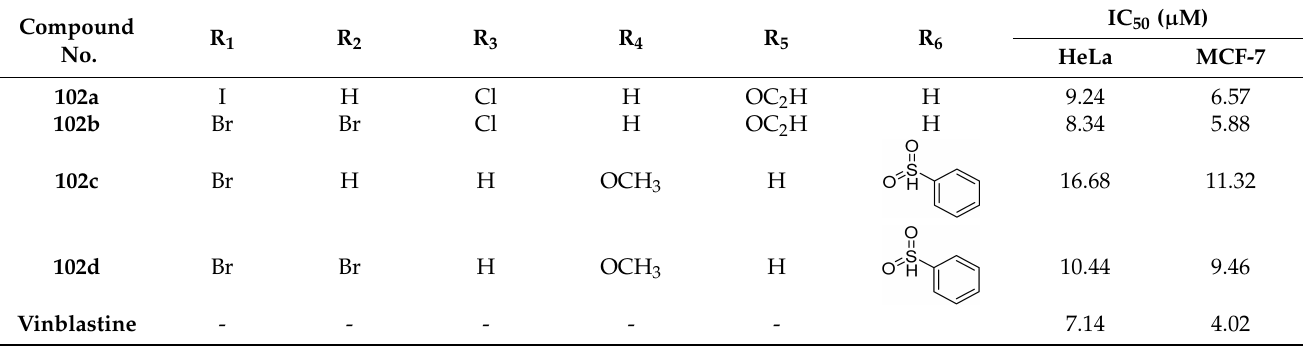
Figure 97. Structure of isatin-benzoic acid derivatives ( 102 ). Table 87. In vitro cytotoxic activities of isatin-benzoic hybrid compounds 102 ( a – d ).